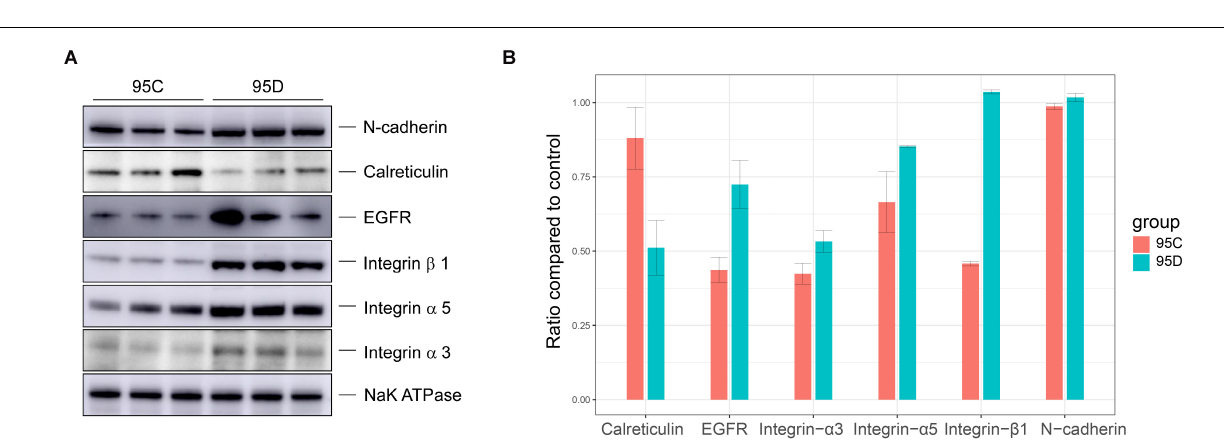
FIGURE 4 | Western blot verification results. (A) Western blot assays of the protein level of CDH2, EGFR, ITGA3, TIGB1, TIGA5, and CALR. (B) The gray levels of Western blotting are shown by bar